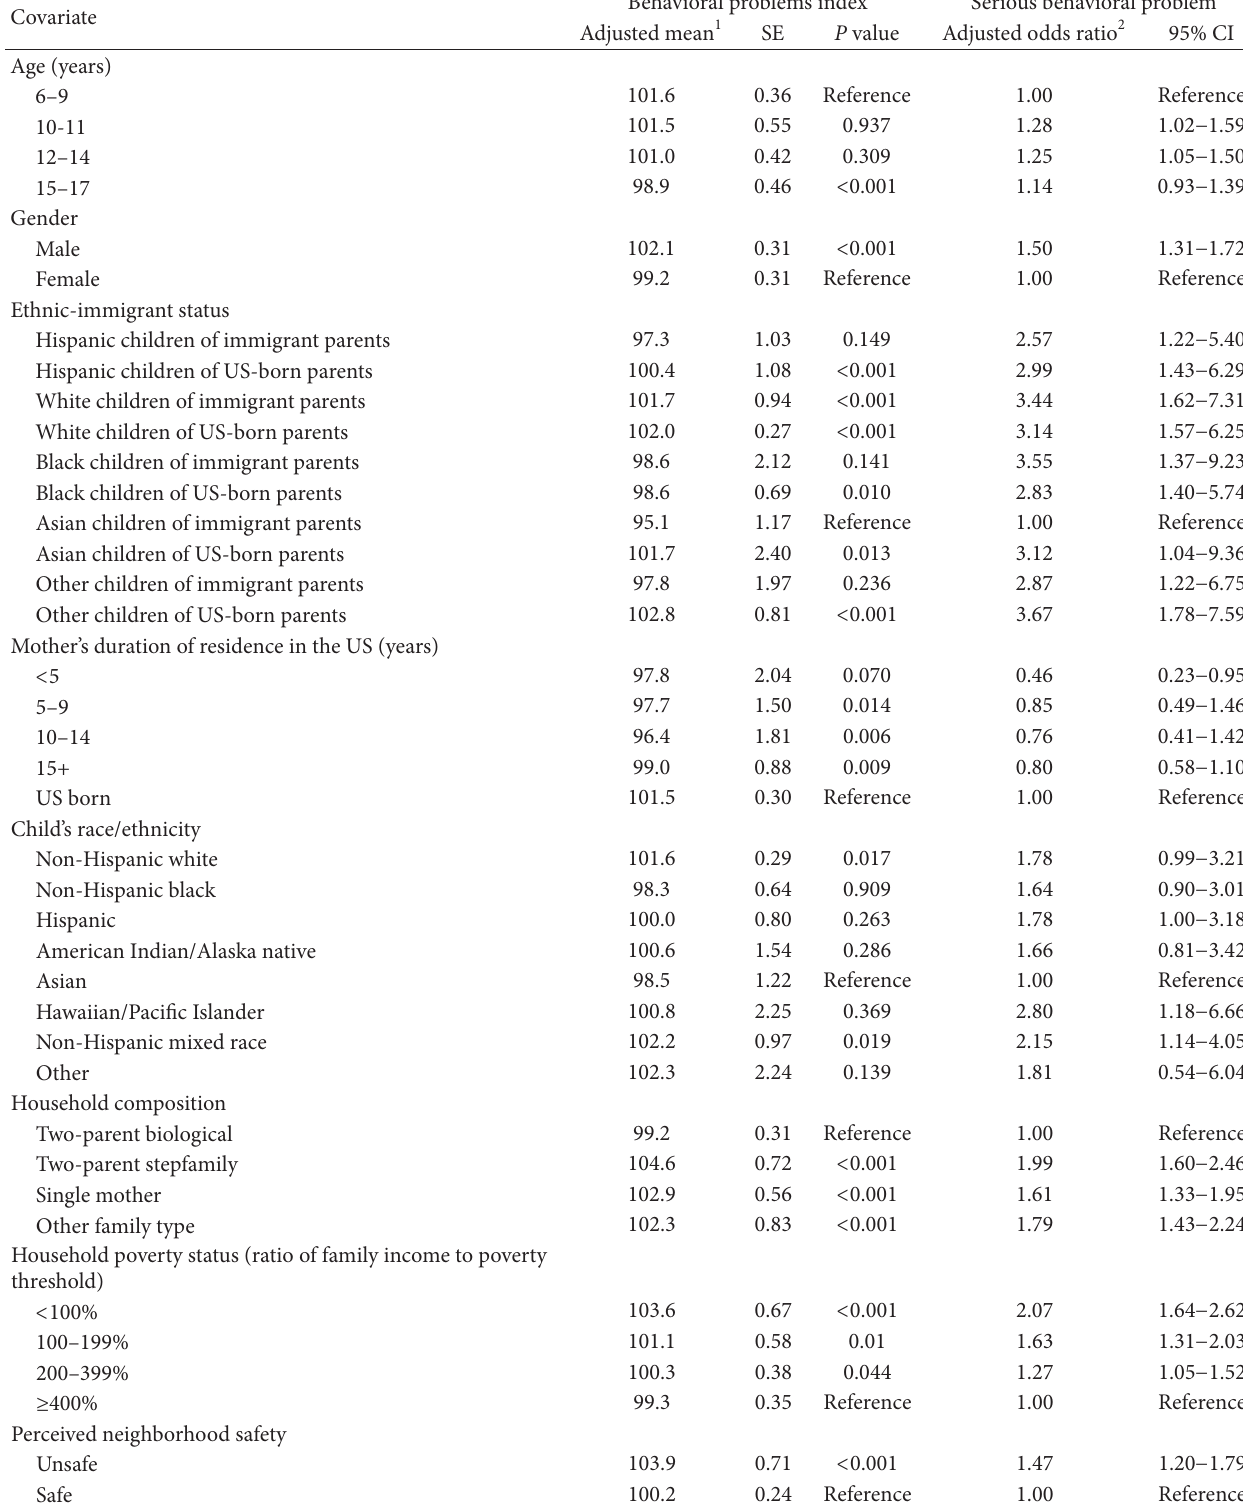
T 5: Multivariate weighted least squares and logistic regressions showing the impact of ethnic-immigrant status and sociodemographic and obesity-related risk factors on behavioral problems among US children aged 6–17 years: the 2007 National Survey of Children’s Health ( N =